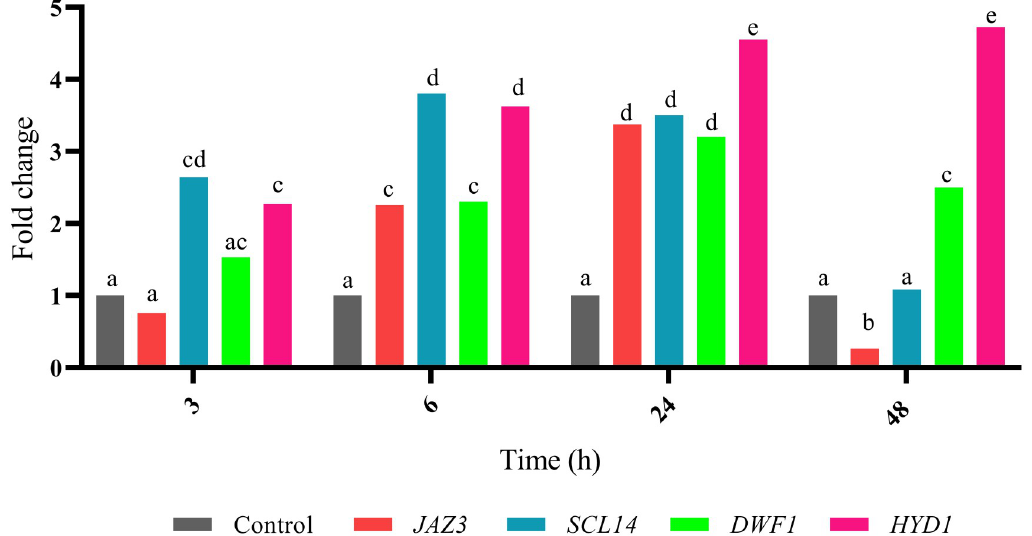
Fig 14. The comparative relative expression of the candidate genes under 100 μ M MeJA treatment in Digitalis purpurea L. Here, the expression pattern of JAZ3 , SCL14 , DWF1 , and HYD1 is compared. X axis represents the fold change of the expression of candidate genes. Y axis represents time points. Vertical bars indicate ± SE of the mean (n = 3). The different letters on columns represent the significant difference given by Duncan’s multiple range tests ( P-value � 0.05). There were no significant differences between equal letters (P-value � 0.05). The interesting point is that the expression of HYD1 , involved in the biosynthesis of cholesterol and subsequently the cardiac glycosides, shows a stable increase after 48 h. In contrast, other genes are suppressing and JAZ3 , inducing the downstream genes, shows a significant